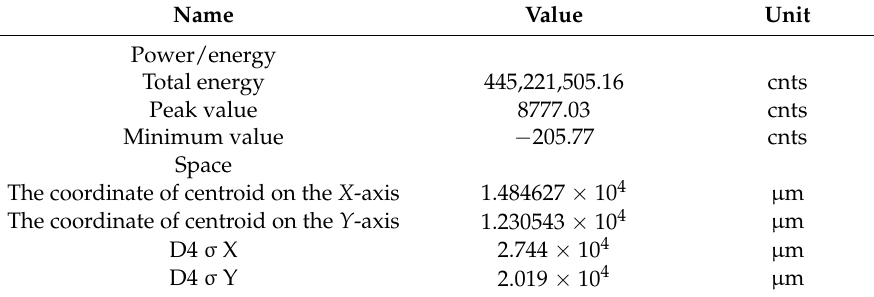
Table 2. Power and space of laser emission